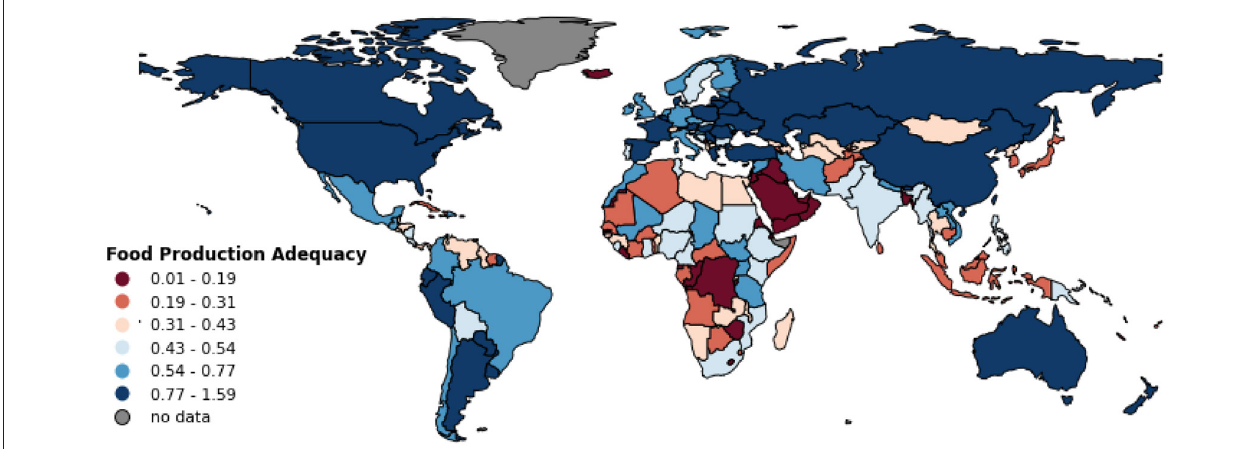
FIGURE 2 | Country-specific Food Production Adequacy for the year 2011–2014. The values represent the minimum of the adequacy ratios for energy and 24 essential dietary nutrients per country. Symbology is based on quantiles classification method.